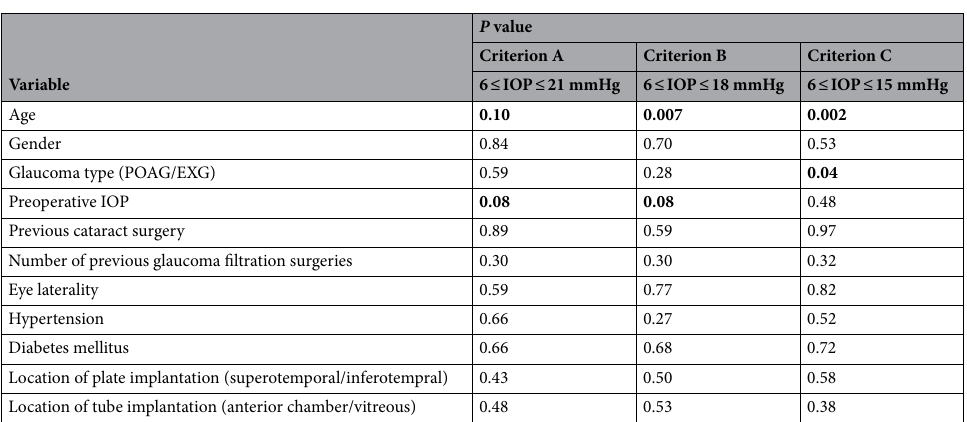
Figure 1. The Kaplan–Meier survival curves for the success probability of BGI of all 51 OAG eyes. ( a ) Criterion A (6 ≤ IOP ≤ 21 mmHg). ( b ) Criterion B (6 ≤ IOP ≤ 18 mmHg). ( c ) Criterion C (6 ≤ IOP ≤ 15 mmHg). The number of eyes at risk is indicated at the bottom. BGI, Baerveldt glaucoma implant; OAG, open-angle glaucoma; IOP, intraocular pressure.